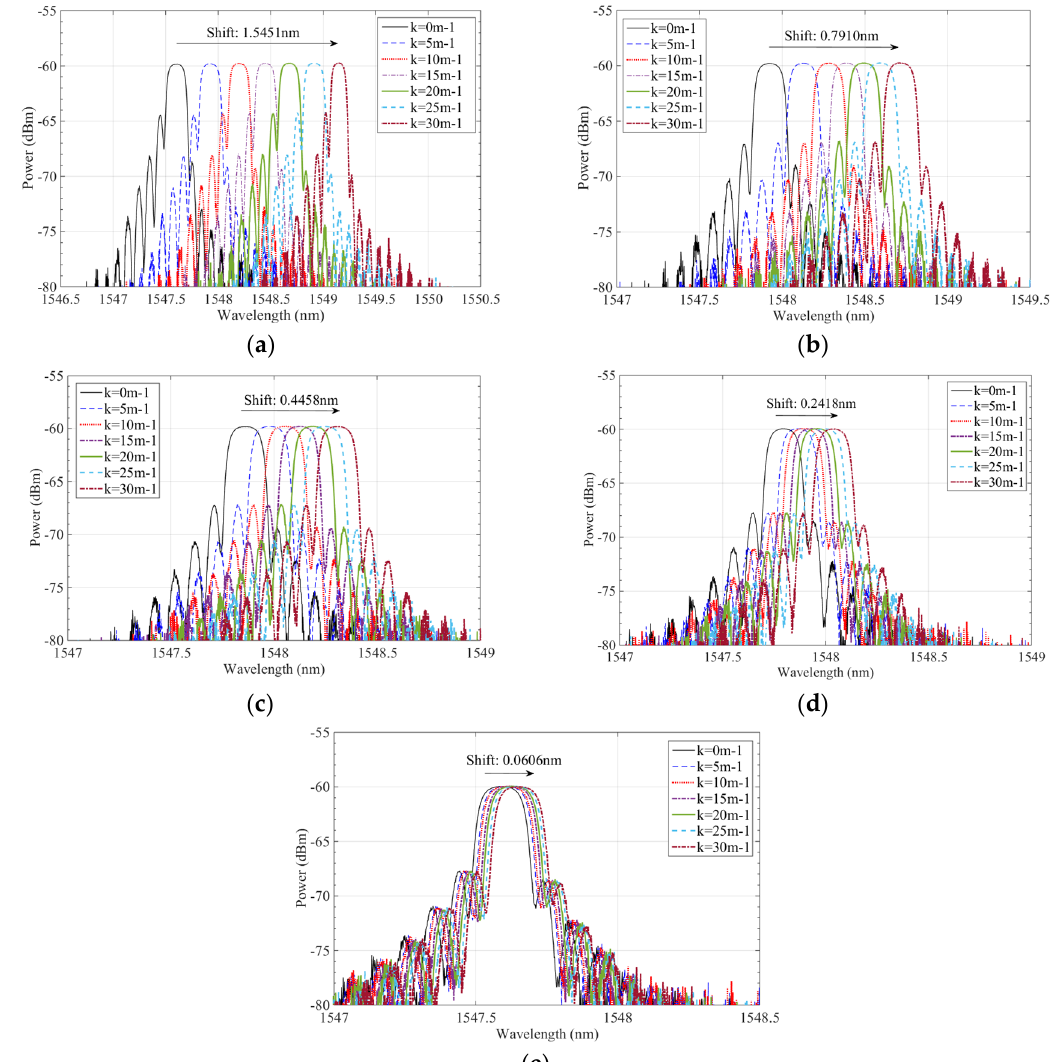
Figure 4. Wavelength shifts and intensities of FBG sensors with different thicknesses. ( a ) Test of sensor No. 1; ( b ) test of sensor No. 2; ( c ) test of sensor of No. 3; ( d ) test of sensor of No. 4; and ( e ) test of sensor of No. 5.